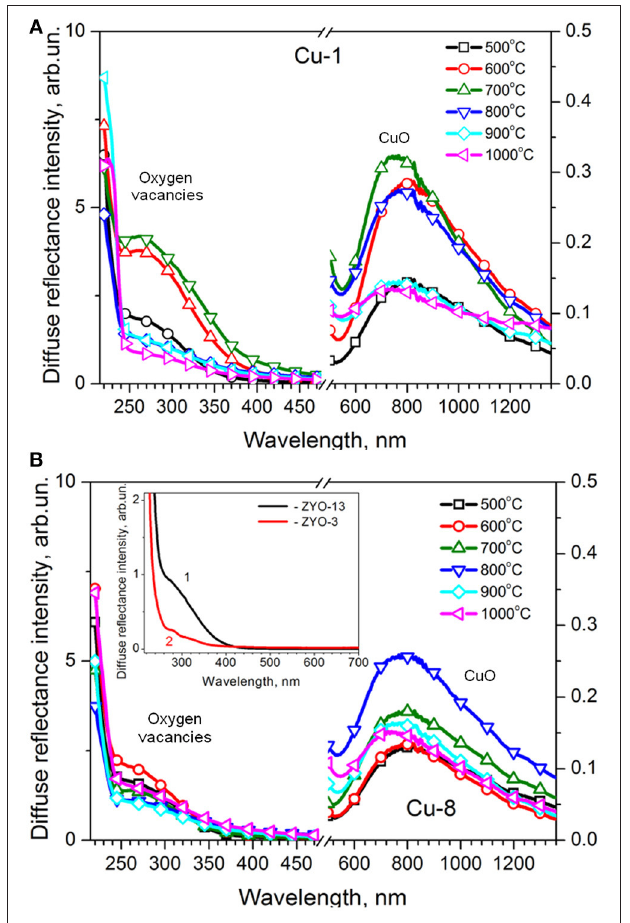
FIGURE 5 | Dependence of intensity of 275nm band (A) and 600–900nm band (B) vs. calcination